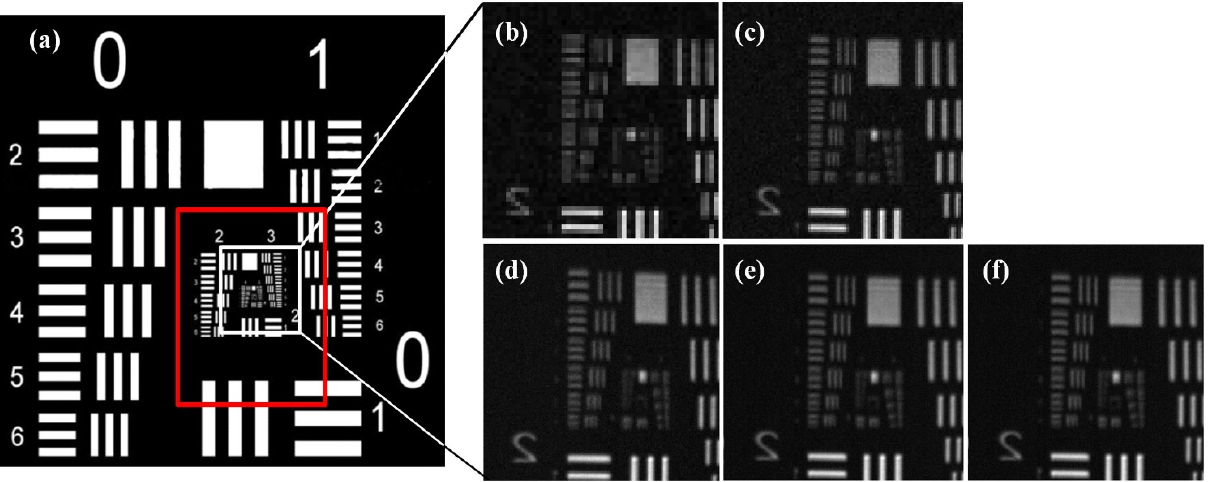
Figure 6. The target and sub-images obtained with different scanning steps. ( a ) USAF 1951 resolution board; scanning steps of ( b ) ~4 μ m, ( c ) ~2 μ m, ( d ) ~1 μ m, ( e ) ~0.8 μ m, and ( f ) ~0.4 μ m, respectively.